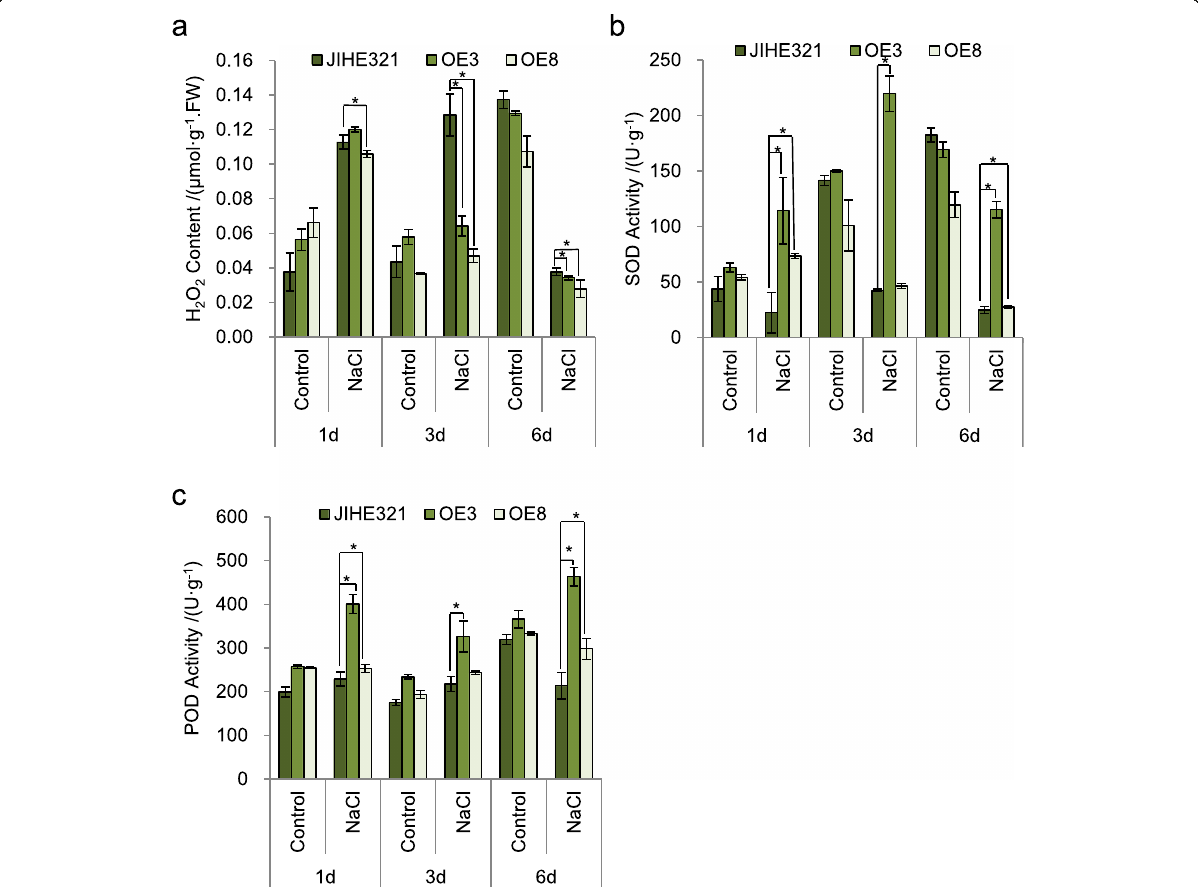
Fig. 5 Ectopic-expression of SAG12::IPT reduces relative H 2 O 2 content, and enhances the activity of antioxidant enzymes in cotton leaves. a Ectopic expression of SAG12::IPT reduces relative H 2 O 2 content in cotton leaves. The third leaf samples (0.5 g) of OE3 and OE8, and control plant were collected as Fig. 4 at indicated time points. b Ectopic expression of SAG12::IPT enhances SOD activity in the third leaf of OE3 and OE8. The samples were collected as ( a ). c Ectopic expression of SAG12::IPT enhances POD activity in the third leaf of OE3 and OE8. The samples were collected as ( a ). The data are shown as means ± SD from three repeats ( n = 3, * P ≤